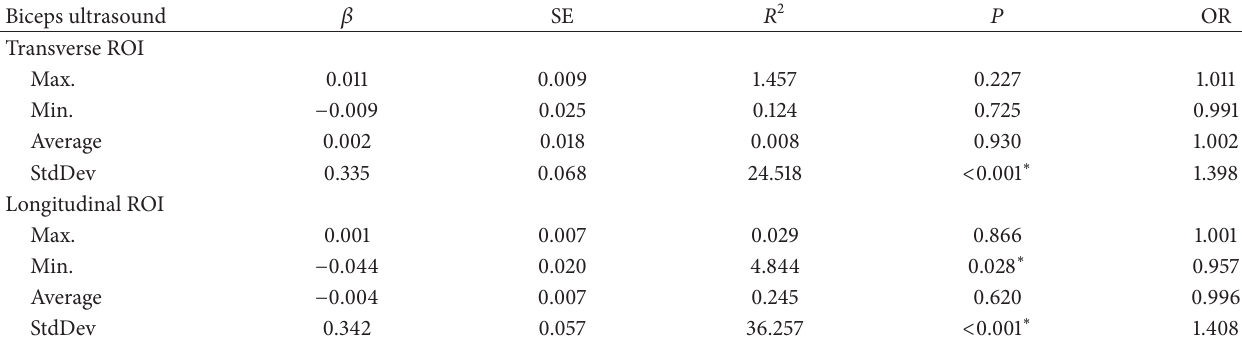
Table 2: Quantitative parameters of biceps ultrasound for predicting biceps tendinitis.